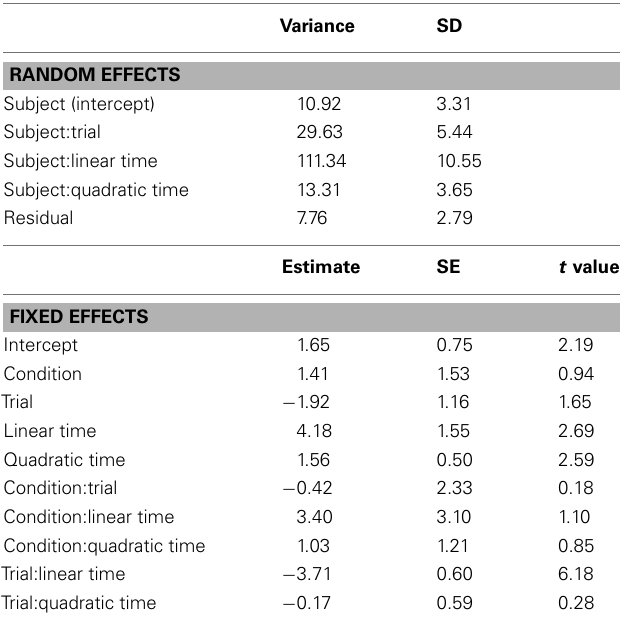
TableA3 | Growth curve model results forTrials 13 and 14 for the full